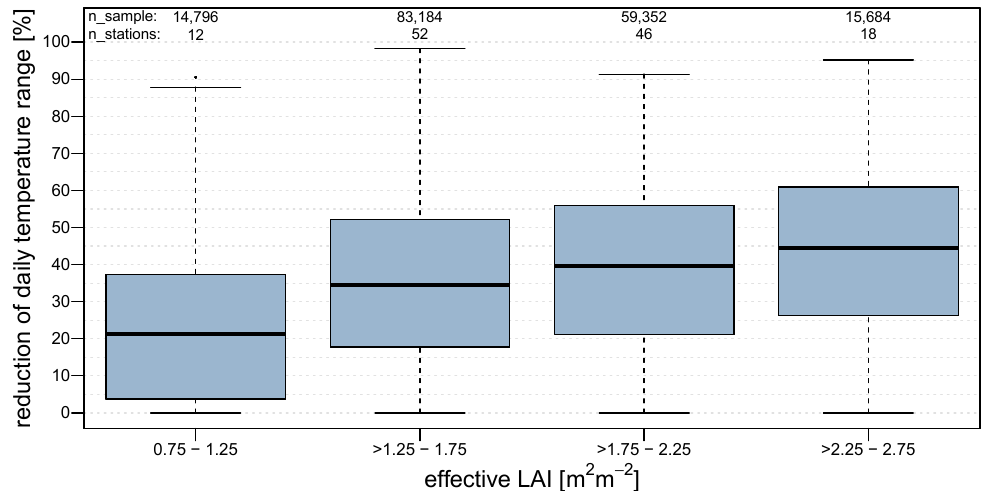
Figure 4. Reduction of the daily range for air temperature due to the forest’s density.